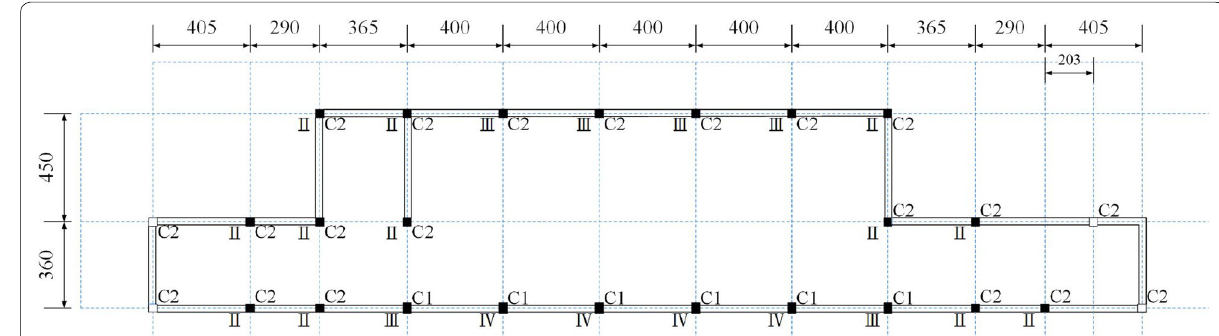
Fig. 21 Damaged column members in the first floor.